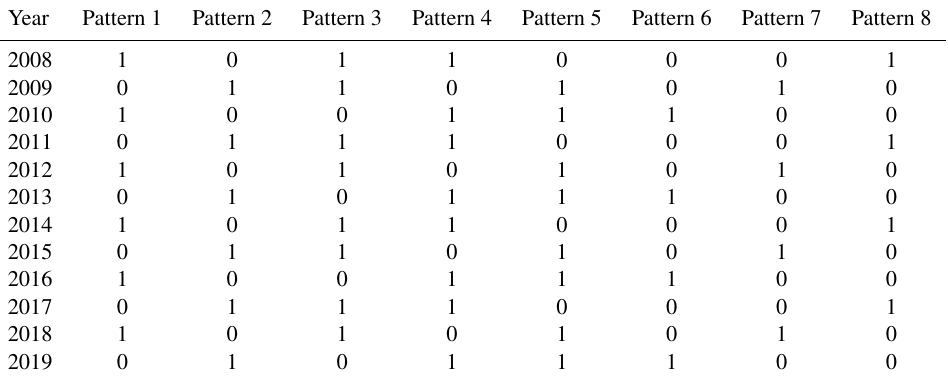
Table 2. Predefined C4-planting patterns from 2008 through 2019. If the C4 crop dominates in a specific year, 1 is assigned. Otherwise, 0 is